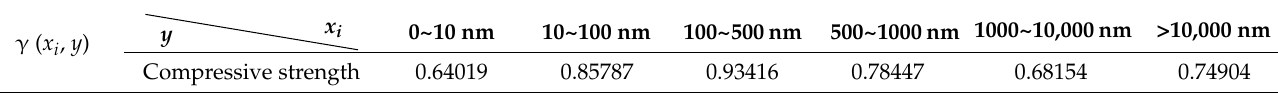
Table 7. Grey correlation coefficients between pore diameter distribution and compressive strength. γ ( x i , y